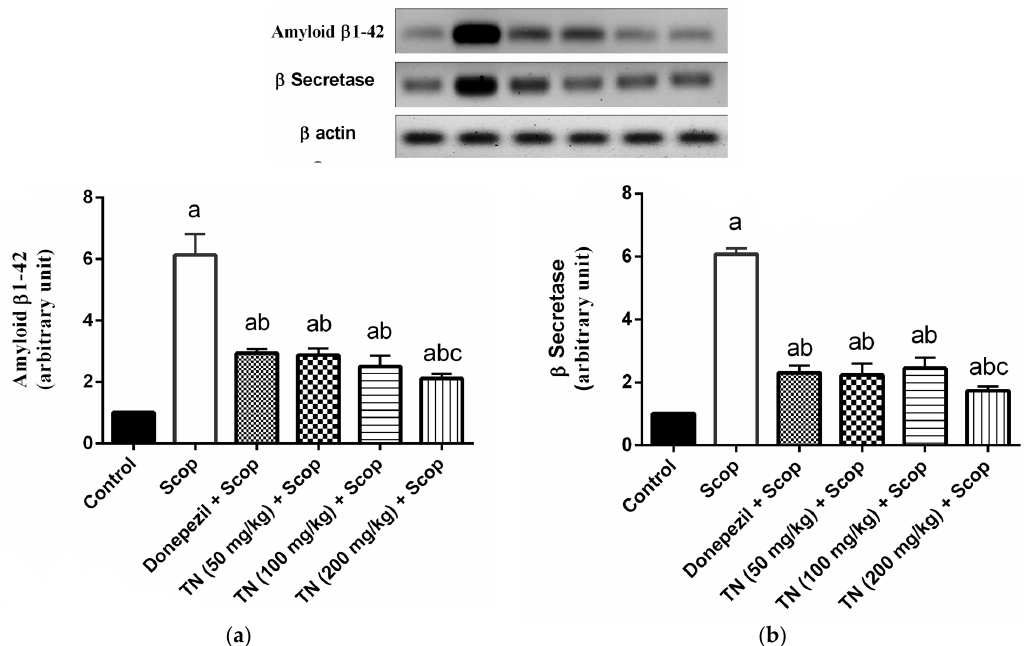
Figure 7. Effect of different doses of TN on Scop-induced alterations in ( a ) A β and ( b ) β -secretase protein expression. Values are expressed as the mean ± SD ( n = 6). Values are statistically significant at p < 0.05 versus the control group, p < 0.05 versus the Scop-treated group and p < 0.05 versus donepezil-treated group. Representative western blots are depicted.